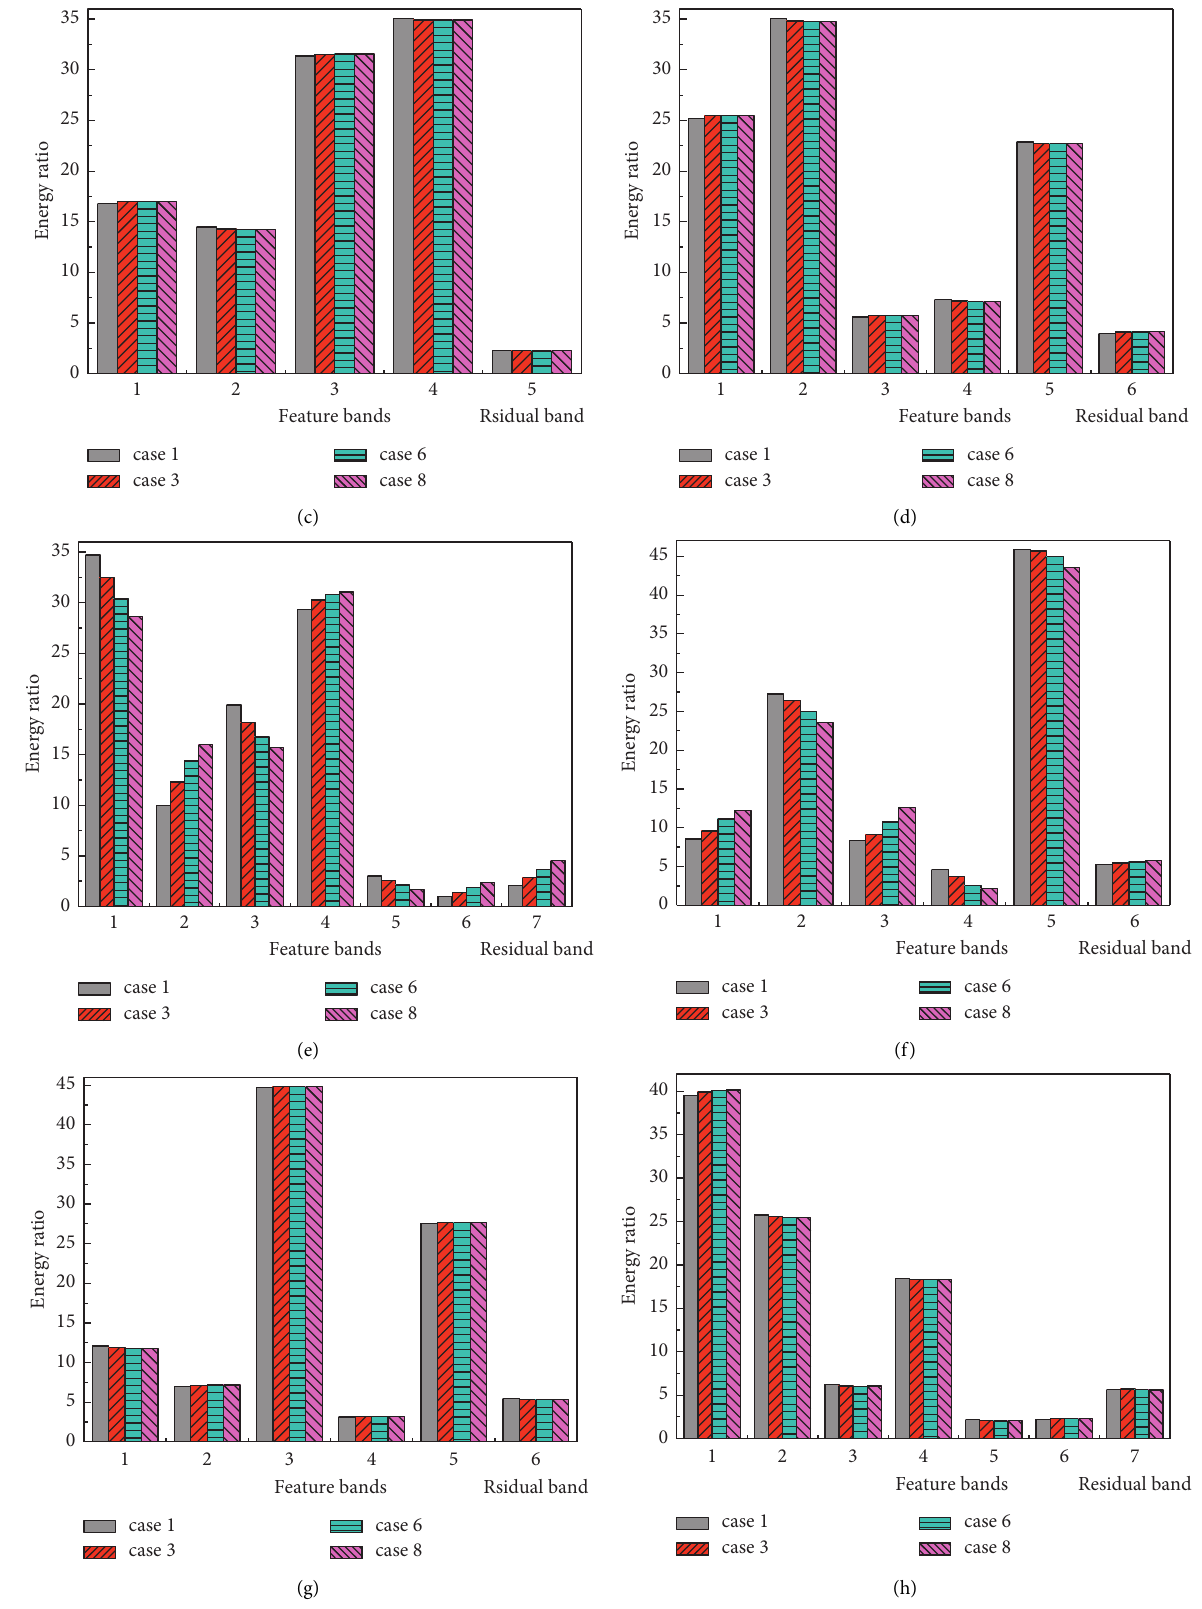
Figure 7: The Hilbert feature vector of IRF and VIRF (the second time test at excitation point I). Point 1: (a) IRF ( ε ( ε 0 � 0.25). Point 7: (c) IRF ( ε 0 � 0.15). (d) VIRF ( ε 0 � 0.25). Point 12: (e) IRF ( ε 0 � 0.15). (f) VIRF ( ε 0 � 0.2). Point 25: (g) IRF ( ε 0 � 0.25). (h) VIRF ( ε 0 �